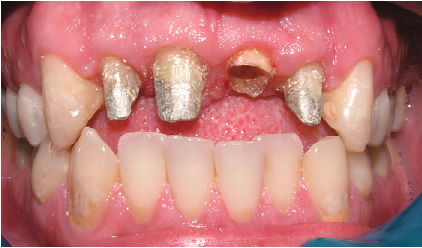
Figure 16: After extrusion and remove of other incisors crowns elastic force.